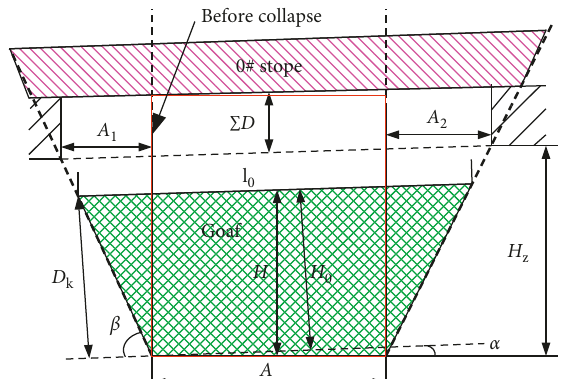
Figure 7: Collapse displacement calculation schematic of the mined-out